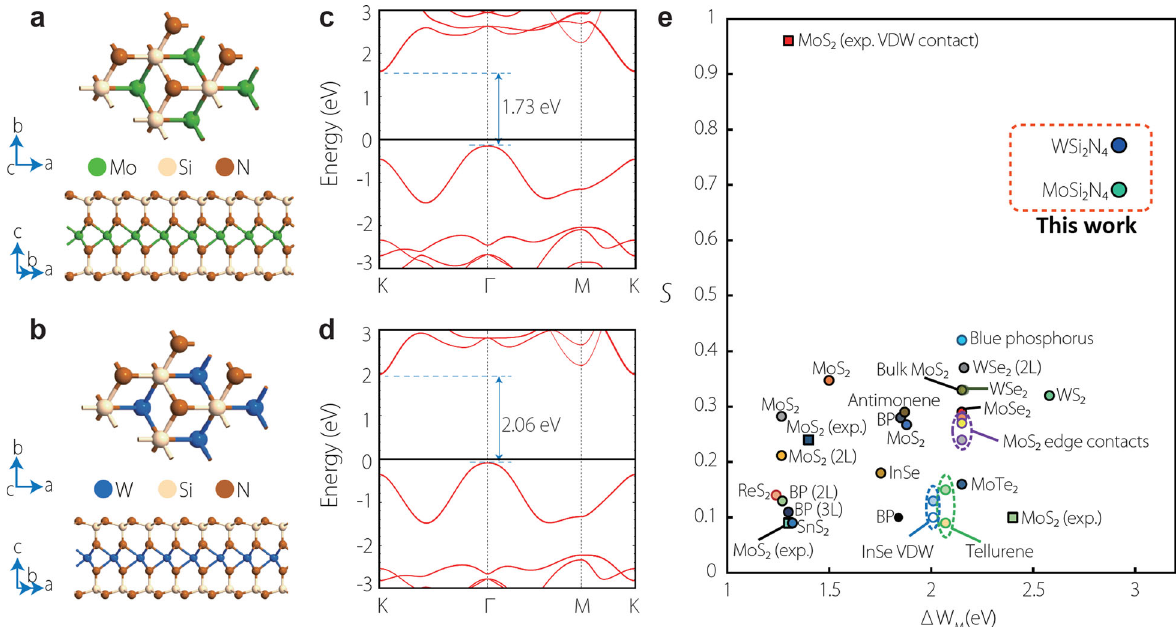
Fig. 1 Lattice structures, energy band structures, and S parameters of MoSi 2 N 4 and WSi 2 N 4 monolayers. a Top and side view of MoSi 2 N 4 monolayer, b same as a for WSi 2 N 4 monolayer, c and d electronic band structures of isolated MoSi 2 N 4 and WSi 2 N 4 monolayer, respectively. e The slope parameter S versus the metal work function range ( Δ W M ) of a large variety of 2D semiconductors, showing exceptionally large S for MoSi 2 N 4 and WSi 2 N 4 . Included are the DFT simulations of MoS 2 [face contact 14,15,27,41 and edge contact 27 ], WS 227,39 , WSe 240 , MoSe 227 , MoTe 227 , black phosphorus 42 – 45 , blue phosphorus 45 , antimonene 46 , tellurene 47 , InSe [3D metal contact 36 and 2D metal VDW contact 37 ], ReS 238 , and the experimental results of MoS 248,49 and SnS 250 . The notations “ 2L ” and “ 3L ” denote bilayer and trilayer, respectively. The MoSi 2 N 4 and WSi 2 N 4 are highlighted by the dashed